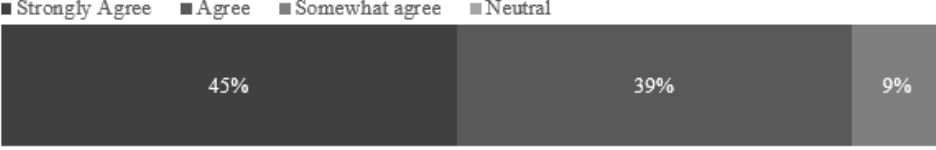
Figure 2: Group 2 student ratings of information on Twitter feed interesting While group 1 engaged positively with the content of the tweets, this was even more evident in group 2. As can be seen in Figure 2, 94% (n=31) of respondents agreed that the information being retweeted was interesting. 88% (n=29) agreed that the information on the newsfeed helped in their understanding of topics. When asked about following research links to original articles, 79% (n=26) indicated that they had. feed during class time. When asked about Twitter use on other modules, 91% (n=30) indicated that they would like to see it used across more modules. Overall, there was responded to the question (n=31) agreeing that the use of technology was useful on their course, with over half strongly agreeing